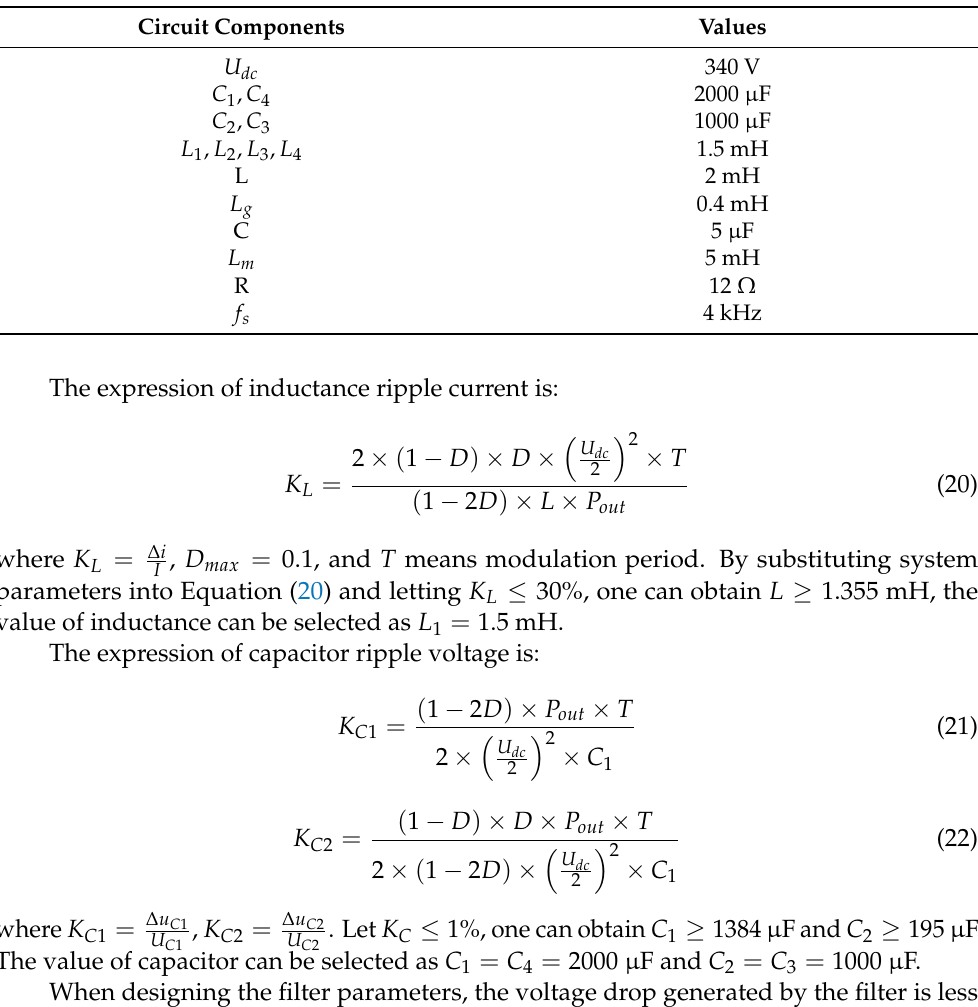
Table 5. Parameters for